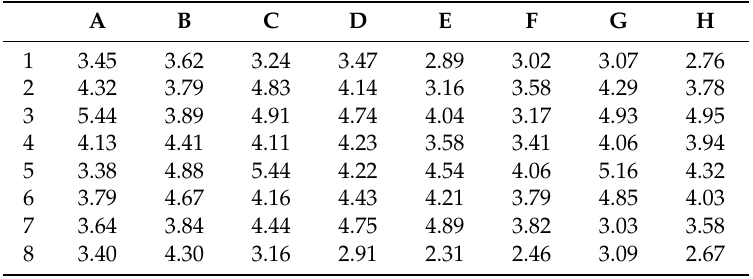
Table A1. Measured values of air velocity distribution in Experiment A1 (m/s).